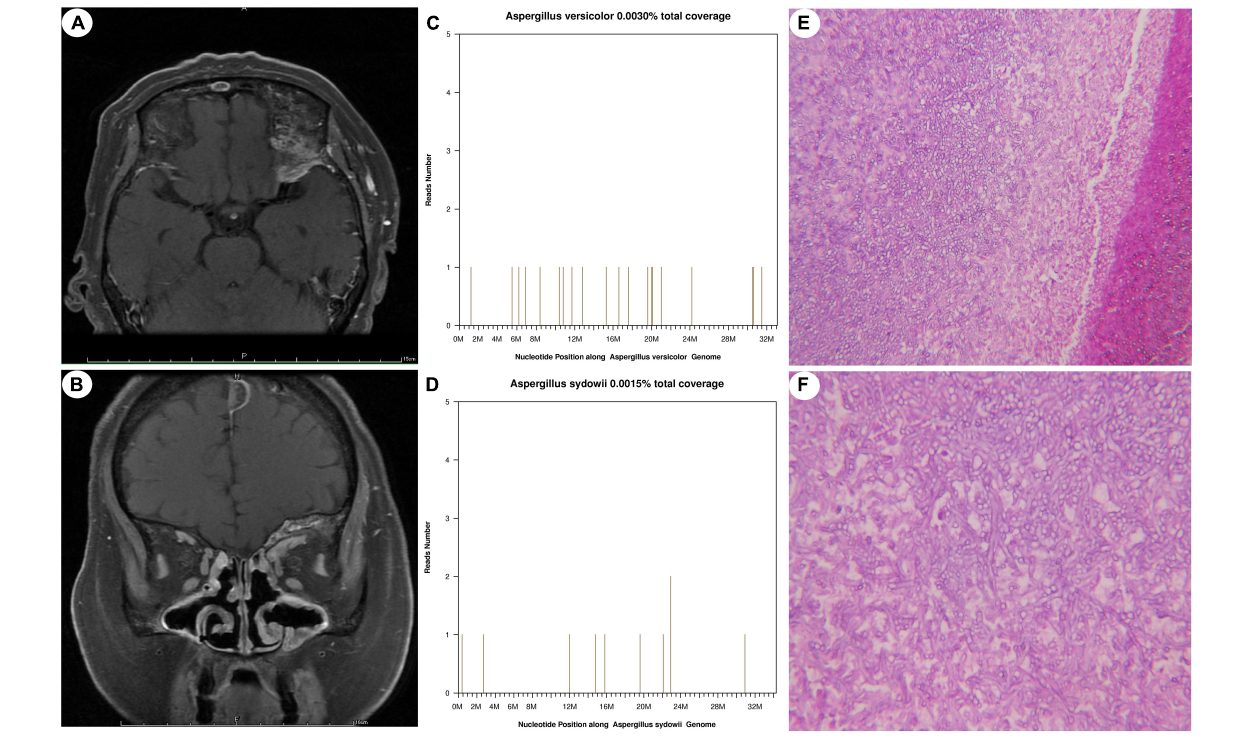
FIGURE 1 | Neuroimaging, mNGS results, and histopathological findings of case 4. T1-weighted MRI with contrast depicting a space-occupying lesion in the left sphenoid sinus and nasopharynx (A,B) . The species-specific read numbers of Aspergillus versicolor and Aspergillus sydowii genomes were 20 and 11, with coverages of 0.0030 and 0.0015%, respectively (C,D) . PAS stain demonstrating Aspergillus hyphae branching at 45 ◦ . Magnification, × 200 (E) , × 400 (F)